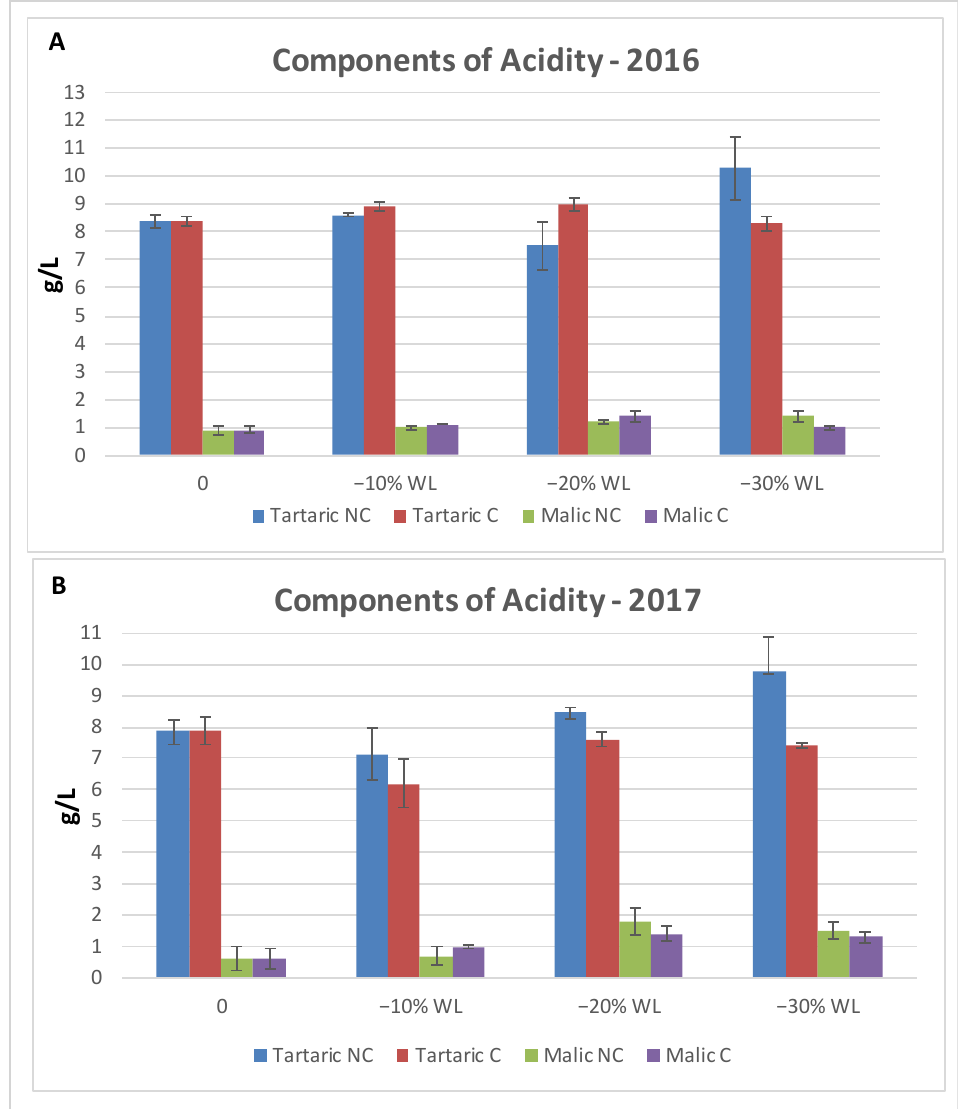
Figure 6. Components of total acidity in 2016 ( A ) and 2017 ( B ). Vertical bars indicate Standard Deviation of 3 analytical replicates. No statistical differences were found.